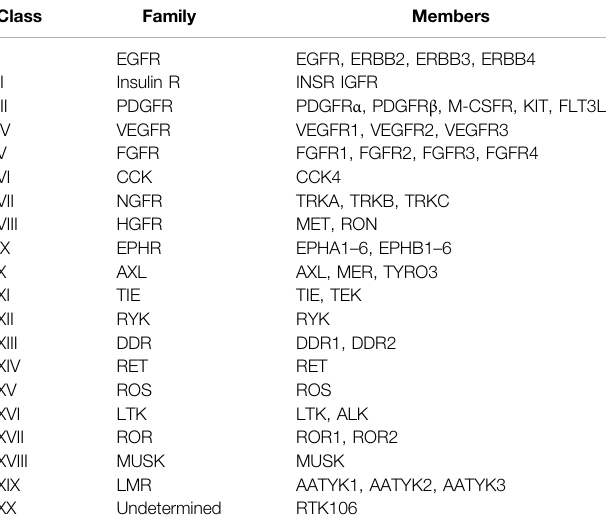
EGFR:epidermalgrowthfactorreceptor;InsR:insulinreceptor;PDGFR:platelet-derived growth factor receptor; VEGFR: vascular endothelial growth factor receptor; FGFR: fi broblast growth factor receptor; CCK: colon carcinoma kinase; NGFR, nerve growth factor receptor; HGFR: hepatocyte growth factor receptor; EphR: ephrin receptor; Axl: from the Greek word anex-elekto, or uncontrolled, a Tyro3 protein tyrosine kinase; TIE: tyrosine kinase receptor in endothelial cells; RYK: receptor related to tyrosine kinases; DDR: discoidin domain receptor; Ret: rearranged during transfection; ROS: RPTK, expressed in some epithelial cell types; LTK: leukocyte tyrosine kinase; ROR: receptor orphan; MuSK: muscle-speci fi c kinase; LMR: Lemur. Adopted from (Ségaliny et al.,